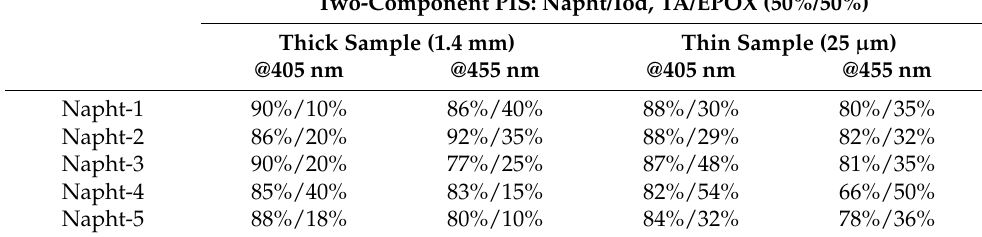
Table 5. Final conversions (FC%) of acrylate and epoxide functions using Napht/Iod (0.05%/1% w/w ) as PIS upon visible light irradiation using different LEDs.